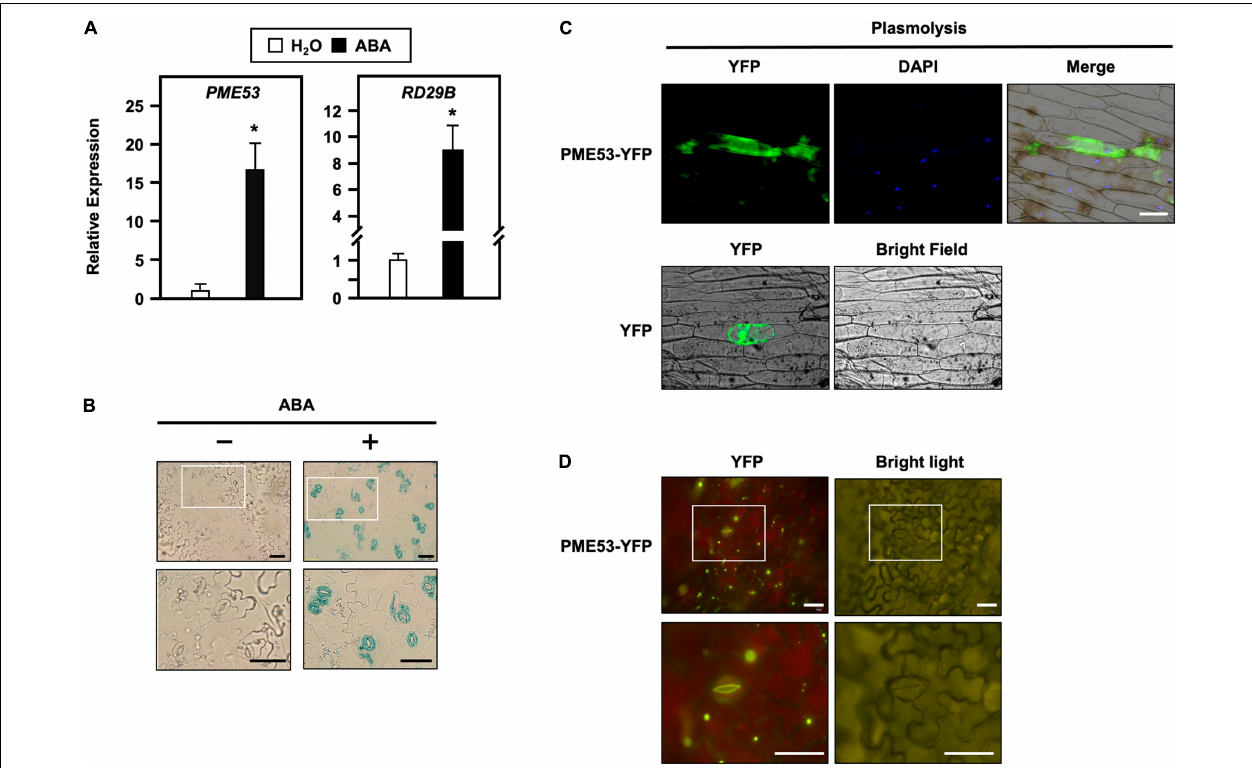
FIGURE 1 | Transcriptional level, tissue-specific expression and subcellular localization of PME53. (A) 7-day-old seedlings were treated without (H 2 O control) or with 100 µ M ABA for 1 h. The expression levels of PME53 were analyzed by q-PCR. RD29B , an ABA-responsive gene, was used as reference. The fold change expression was normalized relative to level of the H 2 O control. Data are mean ± SE of three biological replicates. *Significant at P < 0.05 compared with the H 2 O treatment. (B) Cotyledons of the same PME53 -promoter :GUS transgenic plants treated without (-) or with (+) 30 µ M ABA for 3 h, and then specimens were immersed together in a staining solution. The magnification of the insert (white frame) is shown. Bars = 40 µ m. (C) The onion epidermal cells were treated with mannitol for the plasmolysis assay. Subcellular localization analyzes of PME53-YFP by confocal microscopy. YFP was used as a control. Blue shows nuclei stained with 4 (cid:48) ,6-diamino-phenylindole (DAPI). Bar = 200 µ m. (D) Tobacco cells were infiltrated with Agrobacterium harboring 35S:PME53-YFP transgene. The magnification of the insert (white frame) shows that PME53 is mainly localized in the inner wall layer of guard cells. Bars = 40 µ m.